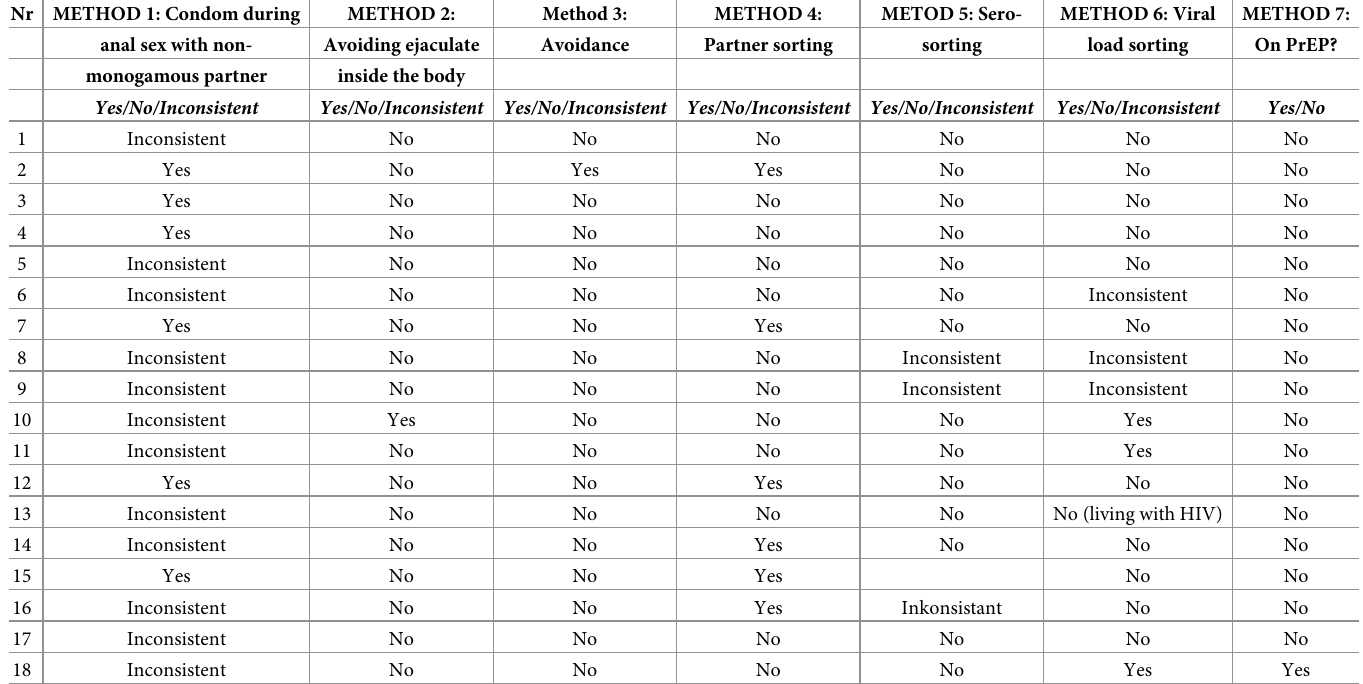
Table 1. List of the seven risk management methods described by each study